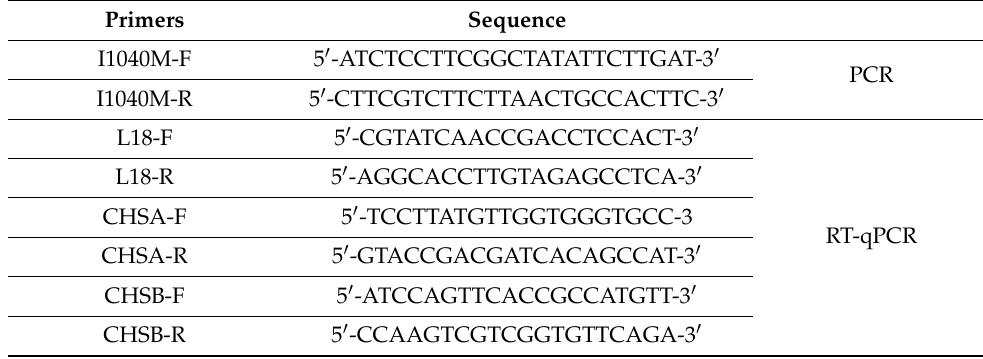
Table 1. List of primers used for pyrosequencing and RT-qPCR.